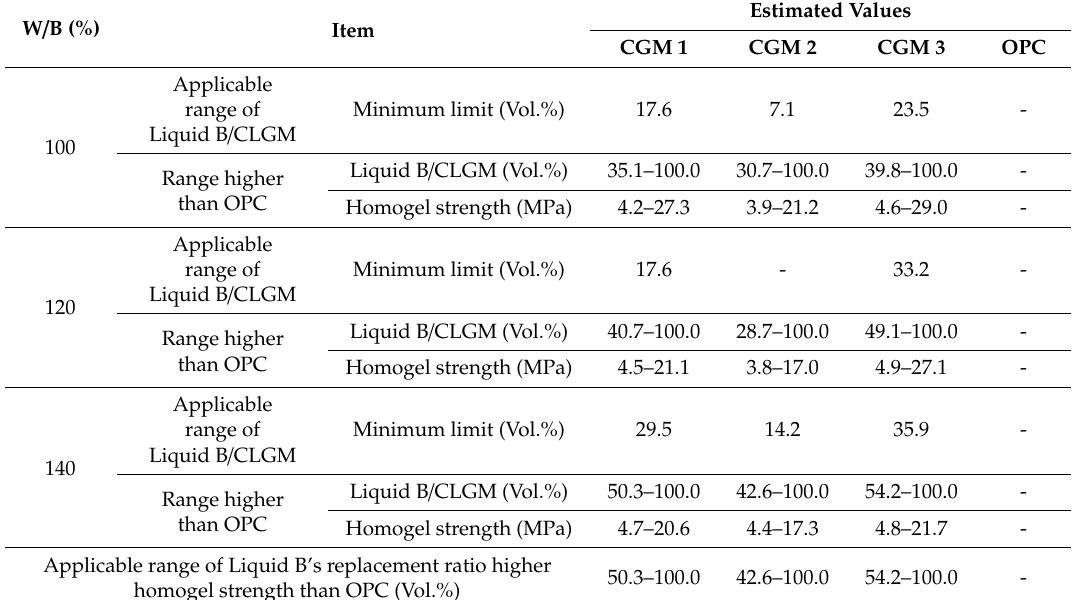
Table 9. Estimated values of homogel strength according to volume replacement ratio of Liquid B (7 days).